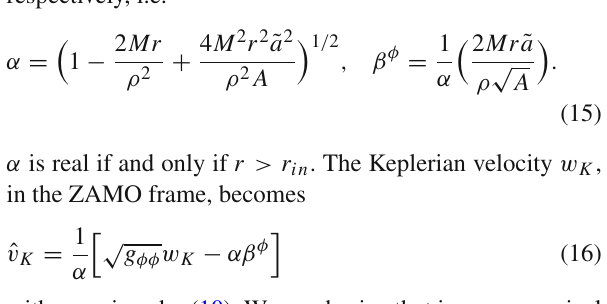
Fig. 1 (Left) Trend of r isco in Lorentz violating Kerr–Sen black hole for different values of the charge parameter b and with l = 0 . 6 fixed. Note that not all values of the spin parameter a are always available. (Right) Trend of the drag effect, (cid:4) = ˙ φ/ ˙ t , as function of the parame-